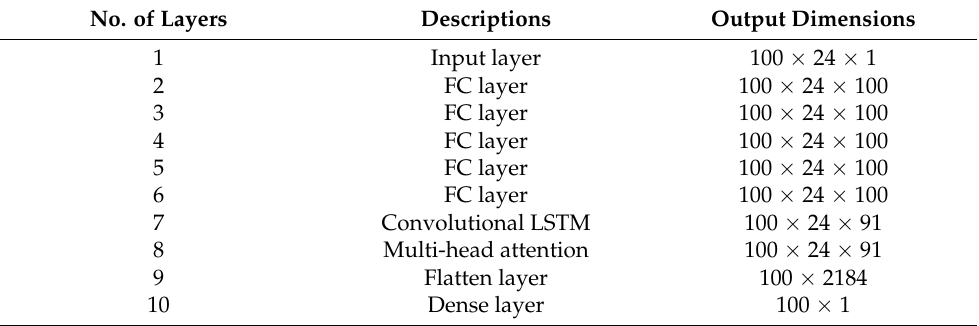
Table 4. The model architecture and hyperparameters used for the next 10th-hour traffic flow prediction